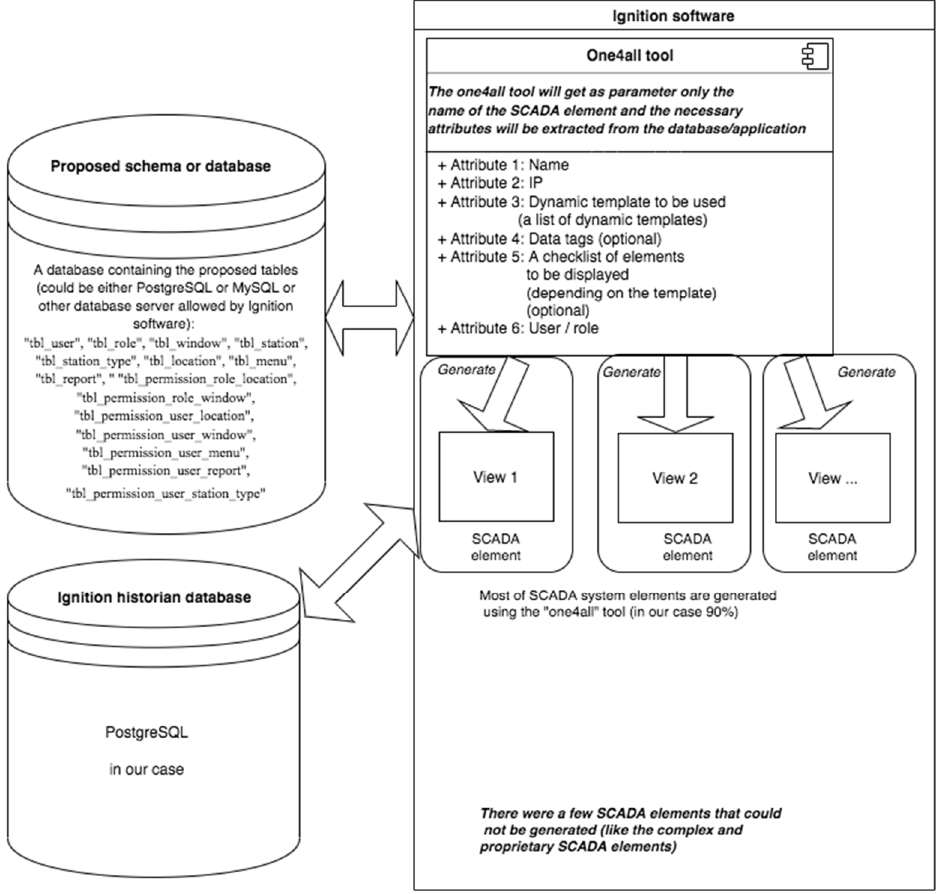
Figure 1. Schema of the “one4all” tool.